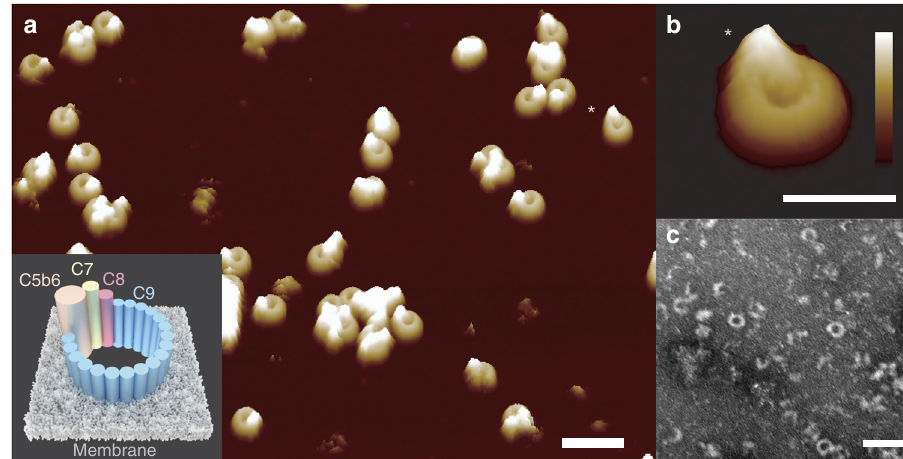
Fig. 1 Formation of MAC on bacterial model membranes. a 3D AFM representation of the endpoint MAC pore structure on supported bilayers composed of an E. coli lipid extract. Inset: Schematic of the MAC, self-assembled from complement proteins C5b6, C7, C8 and C9, embedded within a lipid membrane. b Zoom-in of a single MAC pore (marked with an asterisk in a ). c Negative-stain EM of E. coli lipid bilayers deposited on silicon dioxide grids, sequentially incubated with complement proteins C5b6, C7, C8 and C9, resulting in characteristic MAC rings observed in the bilayer membrane. Scale bars: a , c 50 nm, b 25 nm. Height scale (scale inset in b ), a , b 20